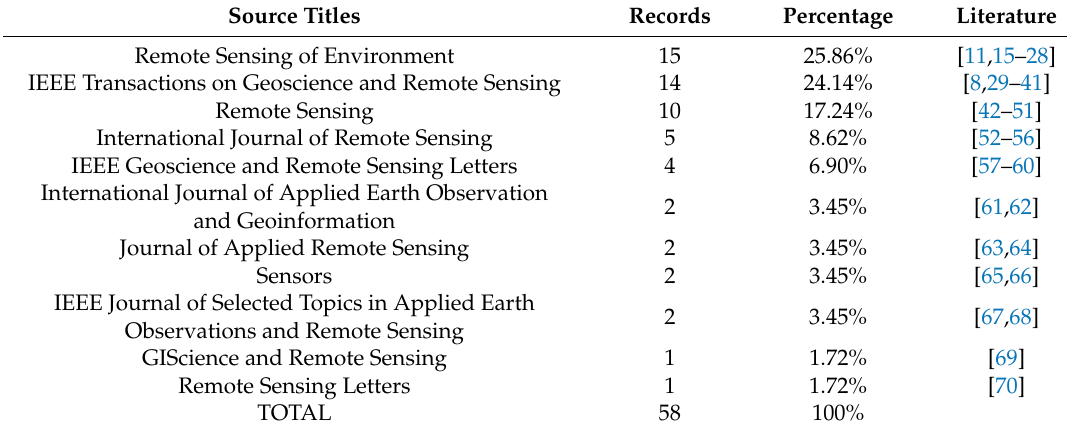
Table 2. Number of methodology papers of spatiotemporal data fusion published in 11 major journals in the field of remote sensing. The search was conducted on 10 March